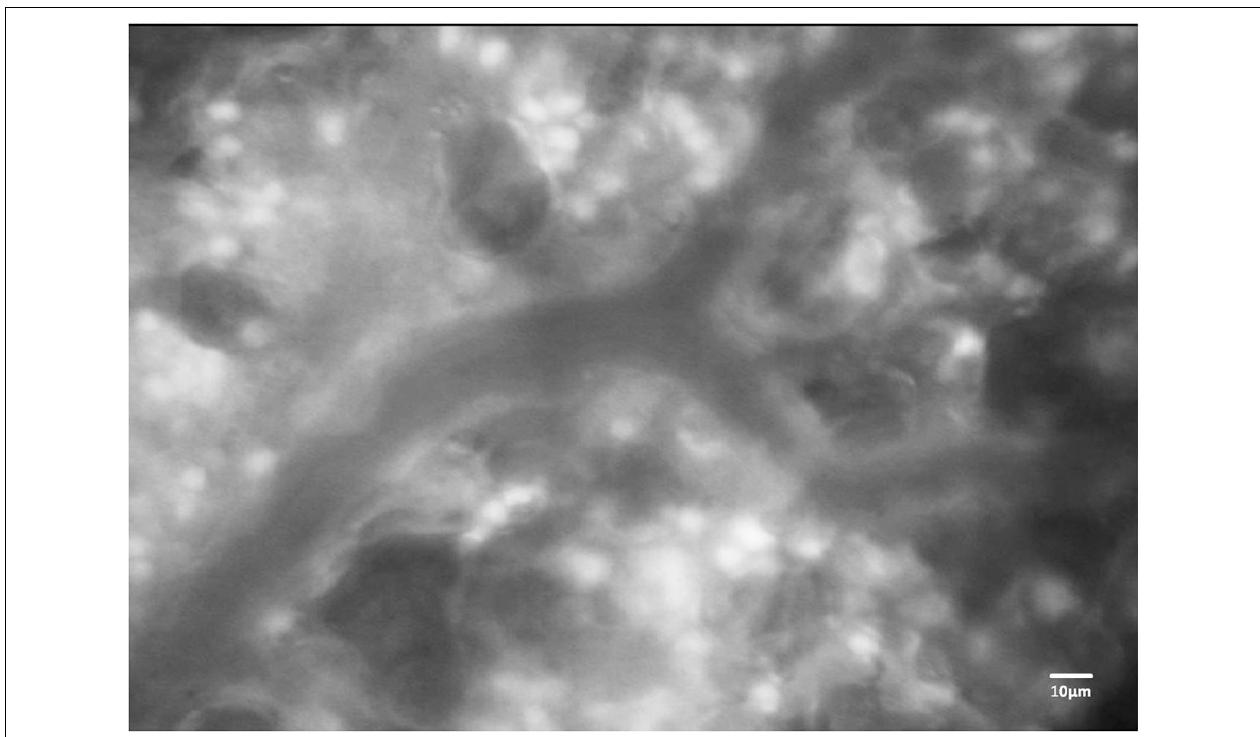
FIGURE 4 | Fluorescence imaging of immune cells in the mouse lung. Representative image of a pulmonary microvessel after i.v. injection of rhodamine 6G. Note the accumulation of stained leukocytes in the alveolar networks outside of the larger pulmonary microvessel in the image center. Ethical approval for the animal experiment was obtained from the Animal Care Committee of St. Michael’s Hospital